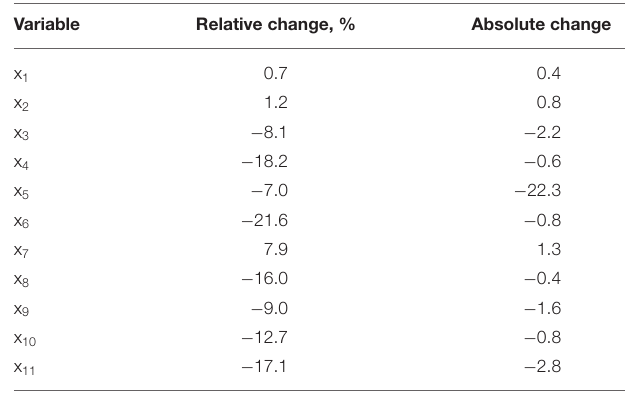
TABLE 2 | Summary statistics of indicators in period 2 (2015-2019). Variable